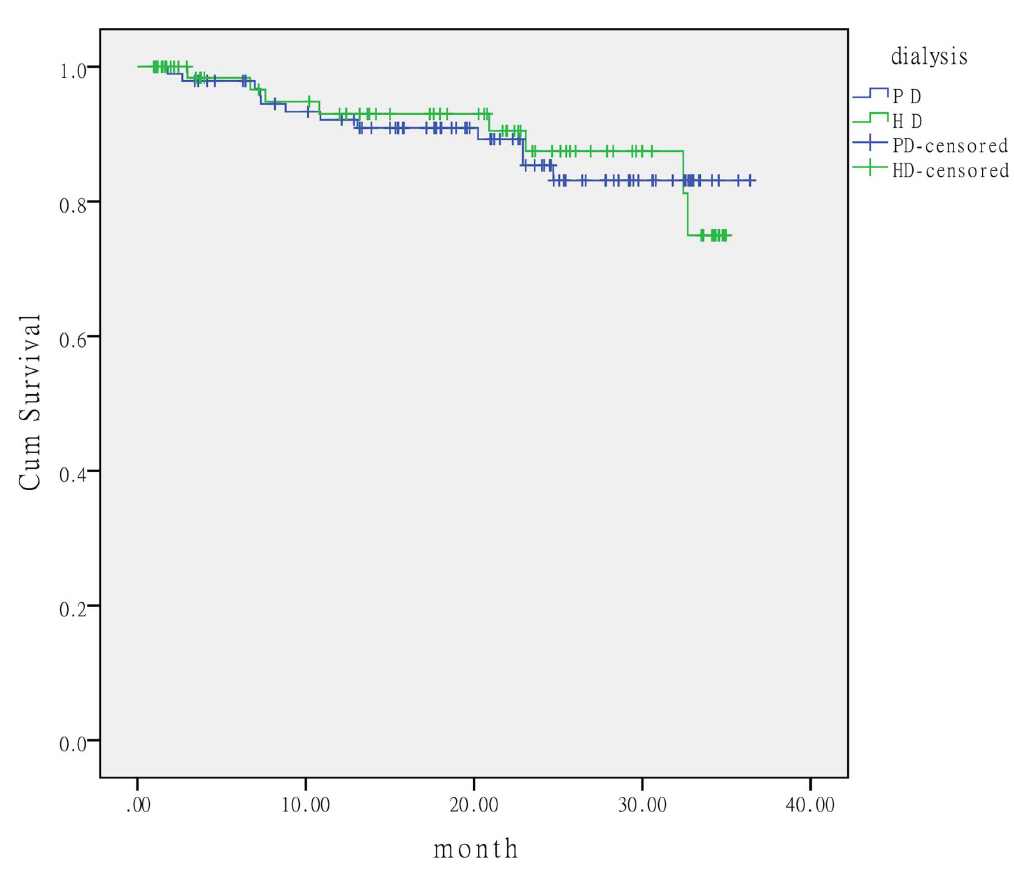
Fig 2. Patient survival curves for study groups. No difference between PD and HD groups in patient survival (log rank, 0.004; p = 0.947). PD: peritonealdialysis; HD: hemodialysis.